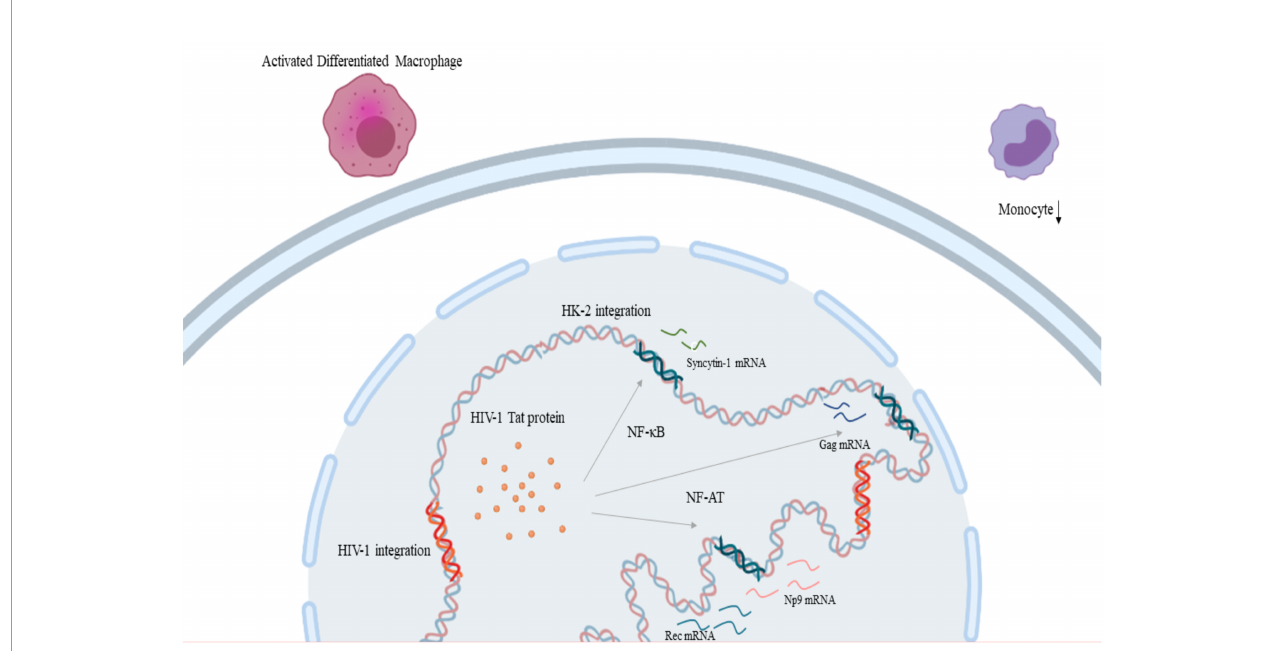
FIGURE 3 | HIV-1 and HERV-K HML-2 interaction in the process of carcinogenesis: HIV-1 Tat protein leads to the upregulation of rec and np9 , and gag expression through transcription factors NF- k B and NF-AT respectively. Also, HIV-1 Tat protein leads to the inhibition of monocytes and stimulation in differentiated macrophages through syncytin-1 expression. (HIV-1, Human Immunode fi ciency Virus 1; HERV-K HML-2, Human Endogenous Retrovirus HML-2). Created in